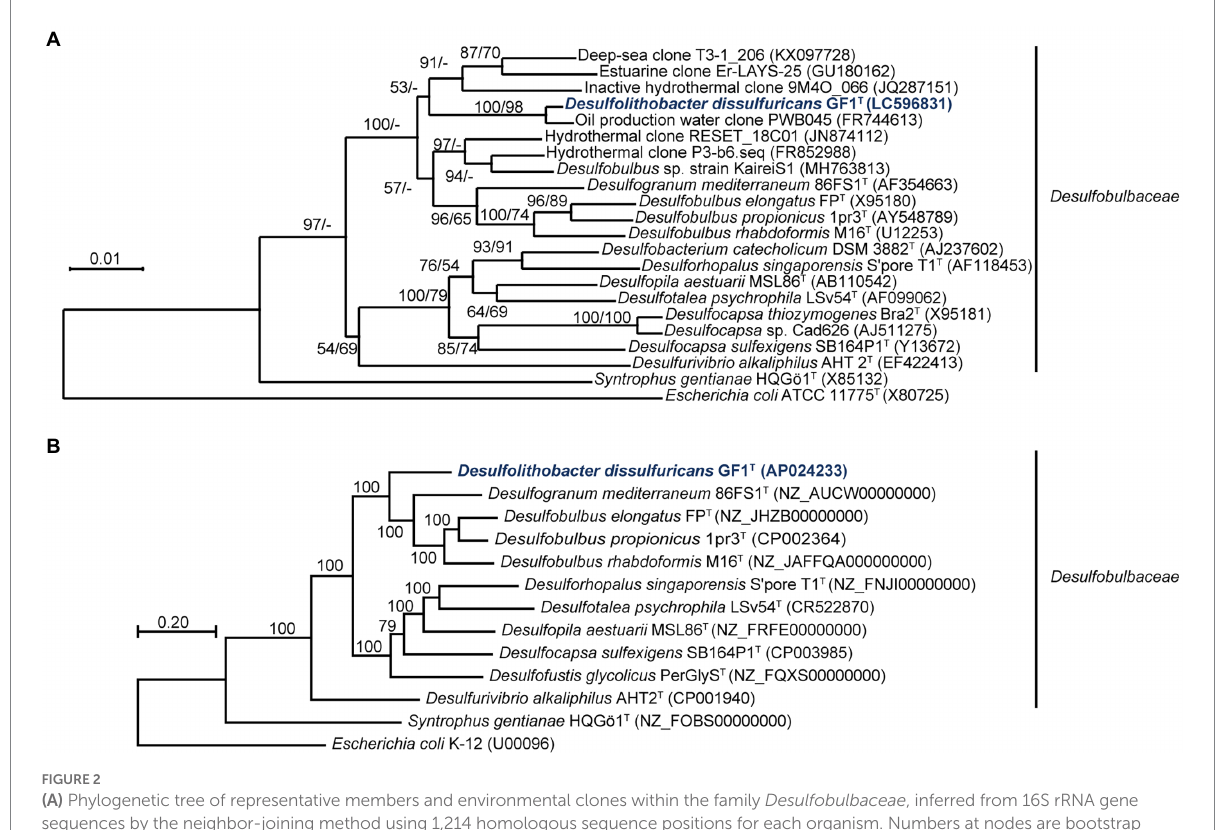
FIGURE 2 (A) Phylogenetic tree of representative members and environmental clones within the family Desulfobulbaceae , inferred from 16S rRNA gene sequences by the neighbor-joining method using 1,214 homologous sequence positions for each organism. Numbers at nodes are bootstrap values (percentages) based on 1,000 replicates (shown in the order neighbor-joining/maximum-likelihood). GenBank/EMBL/DDBJ accession numbers are given in parentheses. Bar, 0.01 changes per nucleotide position. (B) Maximum-likelihood phylogenetic tree of representative members within the family Desulfobulbaceae , based on concatenated 145 single-copy marker genes. Numbers at each node are bootstrap values (percentages) based on 1,000 replicates. GenBank/EMBL/DDBJ accession numbers are given in parentheses. Bar, 0.20 changes per nucleotide